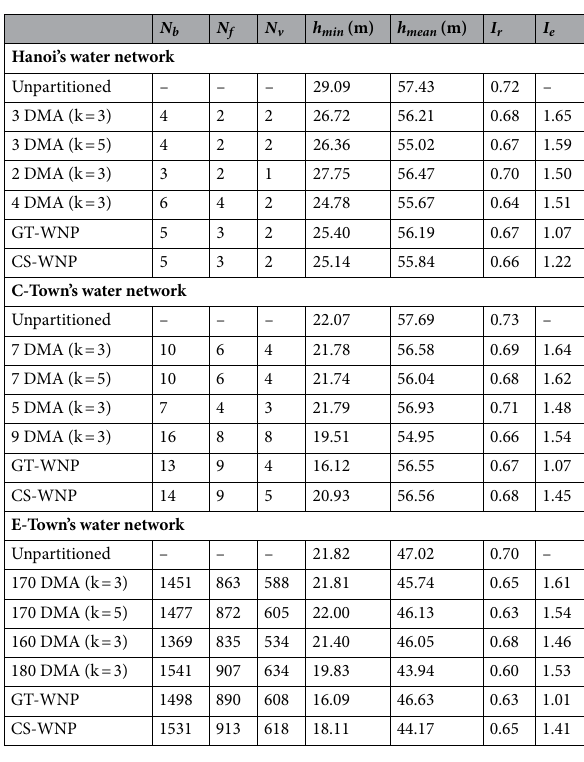
Table 1. Main characteristics and hydraulic performance after WNP.